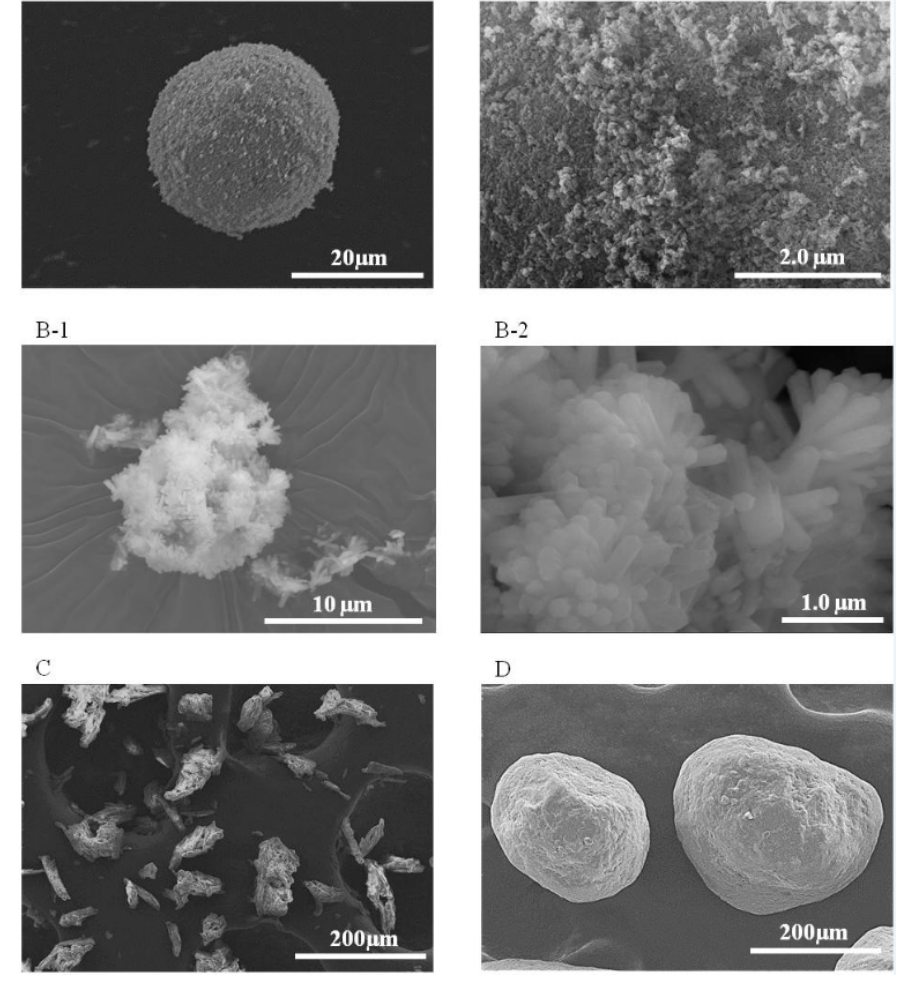
Figure 1. SEM images of the four particulate additives: ( A-1 ) a HApS particle; ( A-2 ) the surface of a HApS particle; ( B-1 ) a HAp200 particle; ( B-2 ) the surface of a HAp200 particle; ( C ) a UF-711 particle; and ( D ) a CP-203 particle.